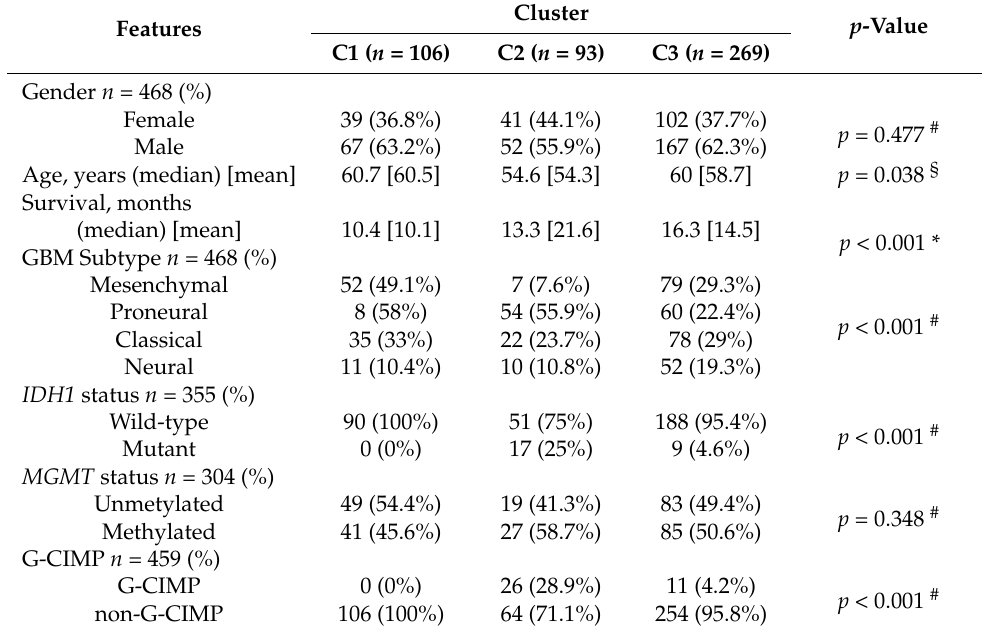
Figure 3. PCA as a complexity reduction model was applied to compress data in to lower-dimensional feature subspace for data visualization. Two-dimensional scatterplot of samples distribution based on to first two PCA (representing 50.8% of data) conducted from 30-gene GSC signature. Table 1. Summarized table of patients demographical, clinical and specimen’s molecular data distribution between